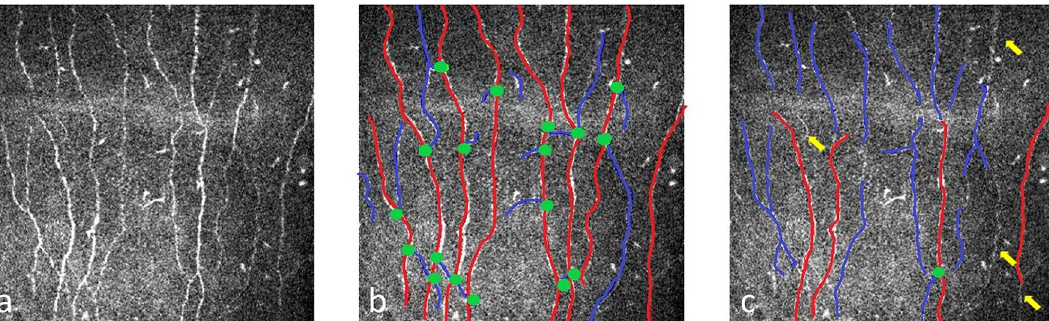
Figure 5. Illustrations representative of (a) , original image from Heidelberg Retinal Tomograph III (HRT III) showing the distribution of sub-basal corneal nerve plexus. (b) , an analyzed image using manual software from CCMetrics (CCM). (c) , an analyzed image using fully automated software ACCMetrics (ACCM). In both (b,c) images, red lines represented main fiber, which was used to calculate nerve fiber density (NFD); green dots represented the junction between the main fiber and the branch fiber (the blue line), which was used to calculate nerve branch density (NBD); NFL, nerve fiber length, represented the total length of red lines and blue lines in the image. The data from CCM (b) had obviously higher NFD, NBD and higher NFL compared to data from ACCM (c) . Yellow arrows in (c) indicated the missing nerve fibers calculated by The intra-observer repeatability of individual observer was assessed using CCM data from both sessions of evaluations, and all 7 observers were examined for their individual repeatability. The inter-observer reliability, left–right eye level of symmetry, and inter-module agreement were examined using data derived from the first evaluation by the 3 observers in the original group. The inter-observer reliability was assessed using CCM meas- urements between any two observers, and the level of symmetry was the correlation between measurements derived from the right and the left eye of the same subject. Statistical analysis. Statistical analysis was performed using Microsoft Office Excel 2019 (Microsoft, WA, USA) and SPSS version 25 (IBM, Chicago, IL, USA). Numerical data were presented as mean ± SD. Differences between measurements using CCM module and ACCM module were evaluated by paired t tests. The intra- observer, inter-observer repeatability and the level of left–right eye symmetry were presented as the Spearman’s rank-sum correlation coefficient (SpCC) for correlation and intra-class correlation coefficient (ICC) for absolute agreement. ICC class (2,1) was used because it was a more conservative estimate of reliability with less bias 27,45 . SpCCs and ICCs were considered excellent if the values were between 0.80 and 1.00 and good if the values were between 0.60 and 0.79. Bland–Altman plots were generated to facilitate appreciation of the extent of intra- observer discrepancy of each morphological parameter 46,47 . Linear regression plots were generated for the sym- metry between two eyes. Bland–Altman plot and liner regression plot were used to show the absolute agreement and correlation between CCM module and ACC module, and the observer in the original group who had the highest intra-observer repeatability in CCM module was chosen for comparison.